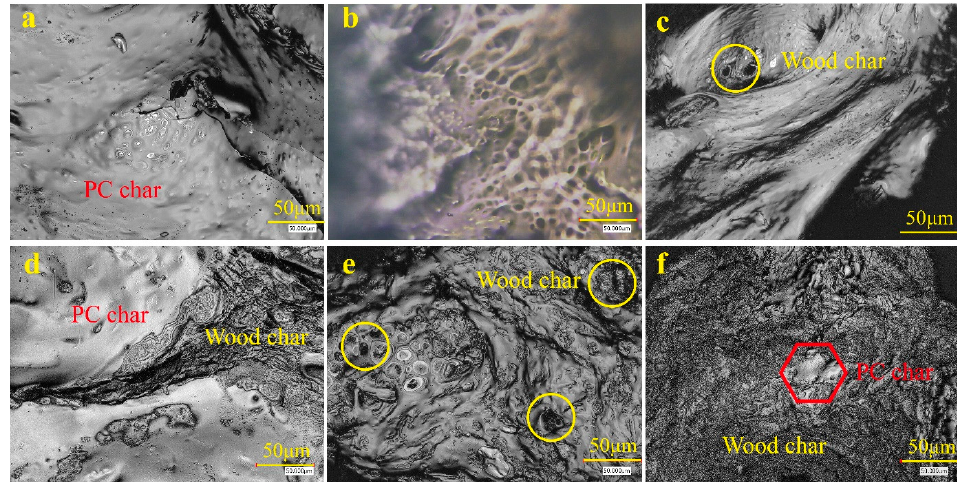
Figure 4. Micromorphology of char formation for wood–PC composites with different wood flour contents after vertical burning test: ( a , b ) 0%, ( c ) 10%, ( d ) 20%, ( e ) 30%, and ( f ) 40%.